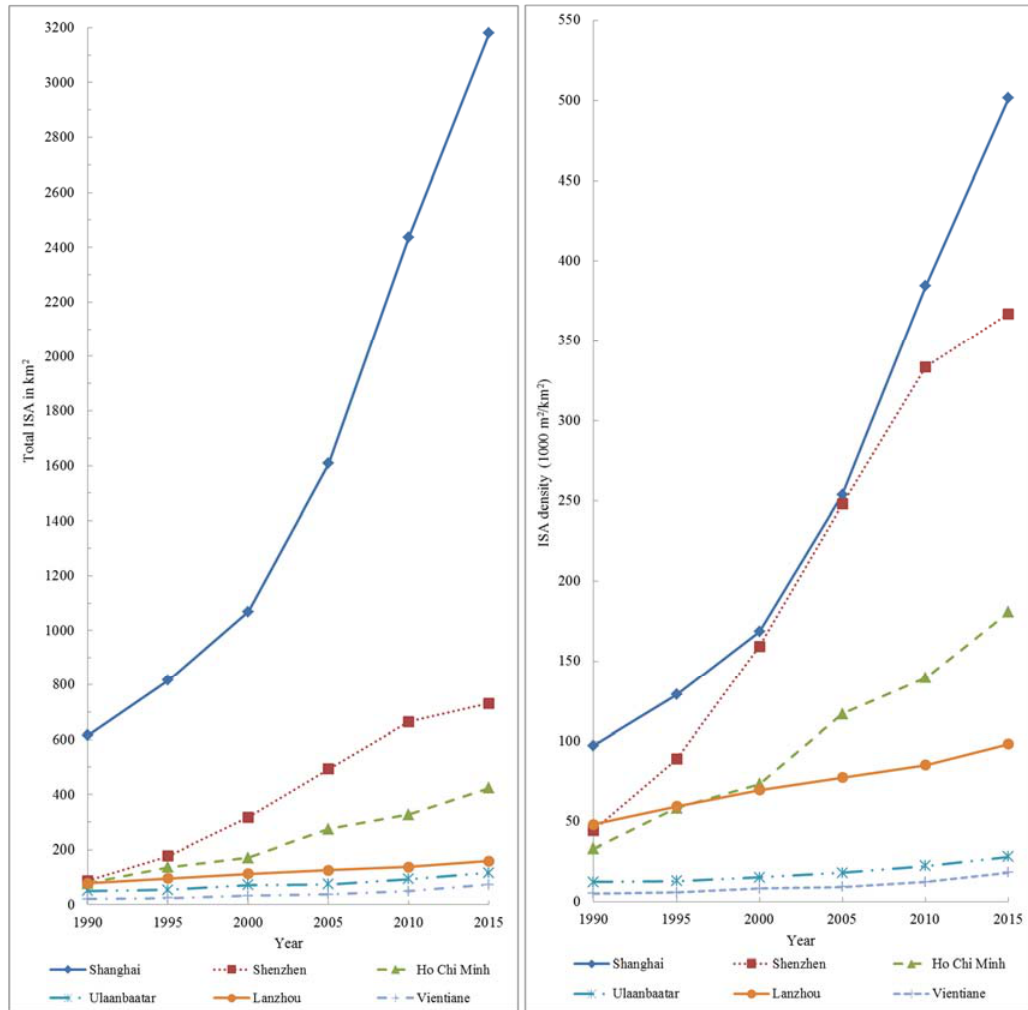
Figure 5. Comparison of total ISA and ISA density among six Asian metropoles.